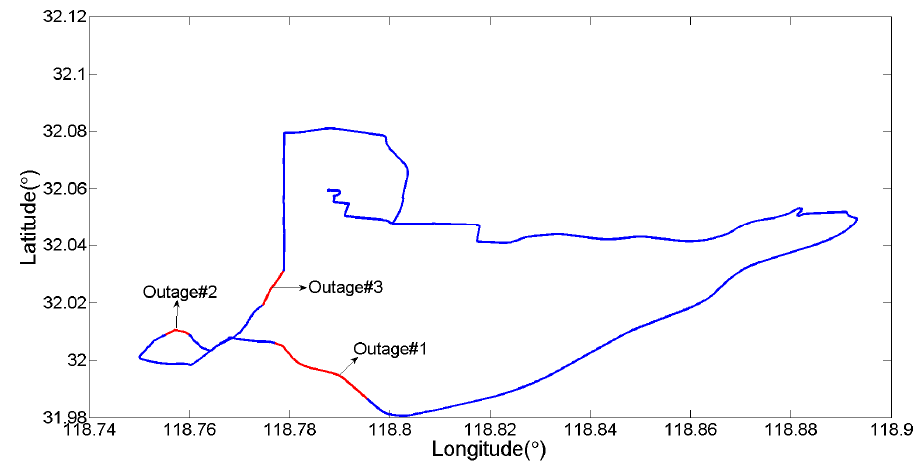
Figure 4. Navigation track.